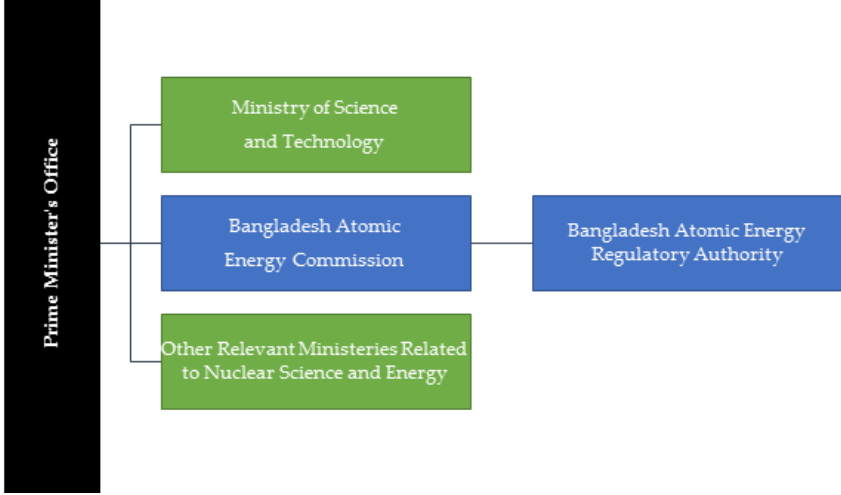
Figure 5. Structure and hierarchy of Bangladesh government related to nuclear affairs.